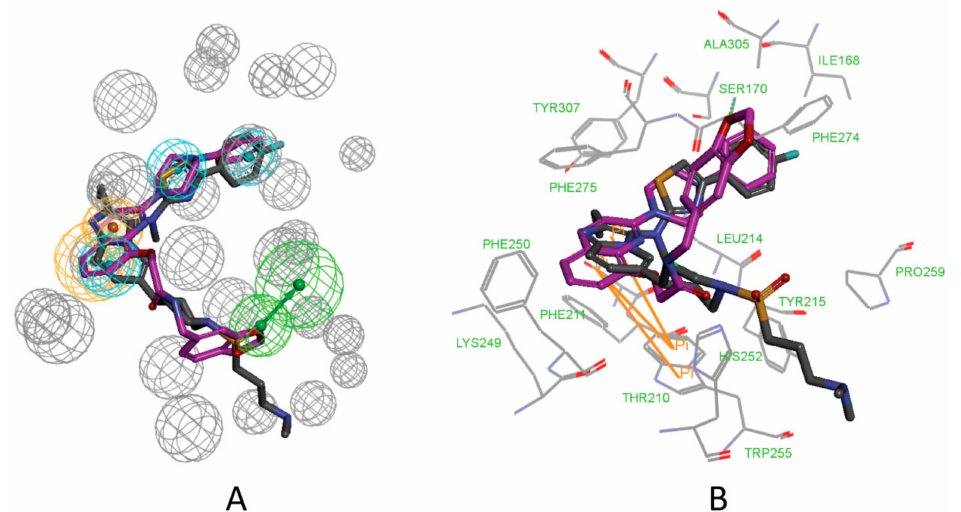
Figure 10. ( A ) Mapping of 5M7M 01 with compound cpd4. ( B ) The possible binding pose of cpd1 in the autotaxin active site. Compound 7HR complexed with autotaxin is also shown for comparison (in gray stick